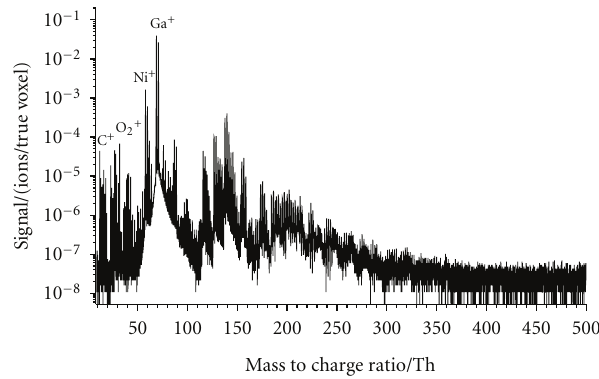
Figure 6: Mass spectrum from nickel finder grid on adhesive carbon patch (see also Figure 4). About six decades of dynamic range are exhibited by this spectrum. Note the relatively large molecular oxygen peak due to the use of oxygen flooding to enhance the nickel ion signal.